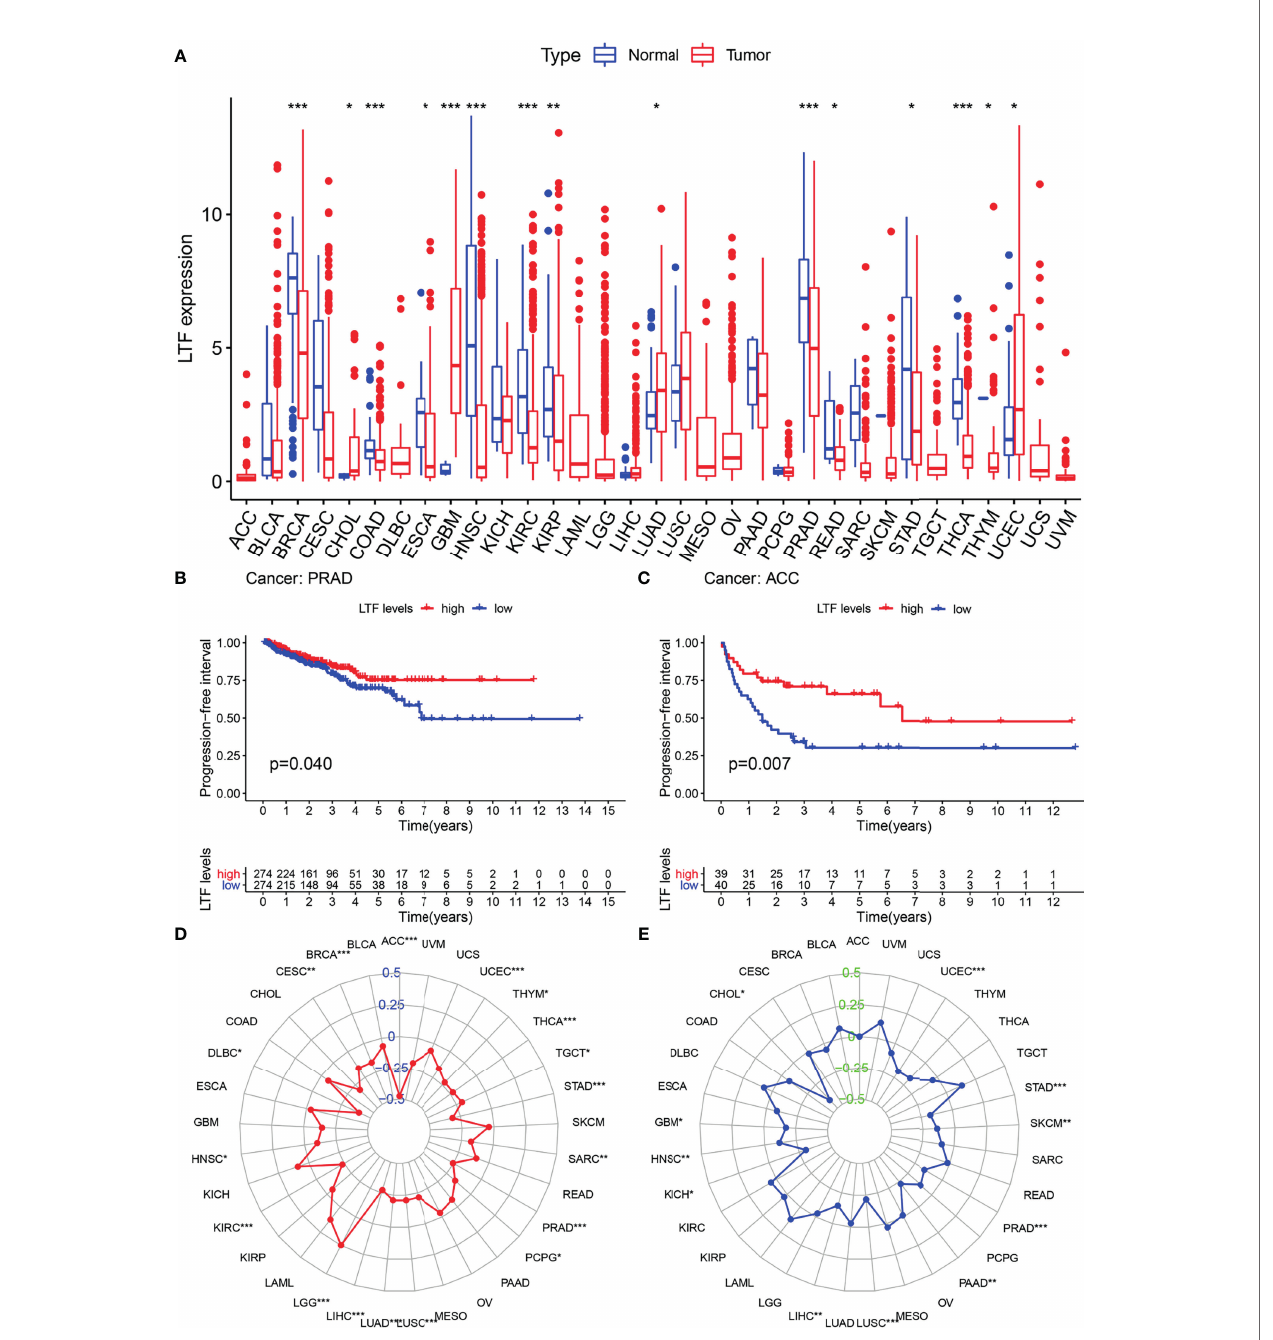
FIGURE 4 | (A) The expression and distribution of lactoferrin (LTF) in cancer tissues and paracancerous normal tissues of 33 tumor types. Red indicates tumor tissues, and blue indicates normal tissues (***0.001, **0.01, *0.05, “ “ 1). (B, C) Kaplan – Meier method was used to analyze the progression-free interval rate of patients, and it was found that patients with high LTF expression group were signi fi cantly higher than those with low LTF expression group. (D, E) Tumor mutational burden (TMB) (D) and microsatellite instability (MSI) (E) correlation radar chart visualizes the TMB and MSI correlation of LTF in each tumor (***0.001, **0.01, *0.05, “ “